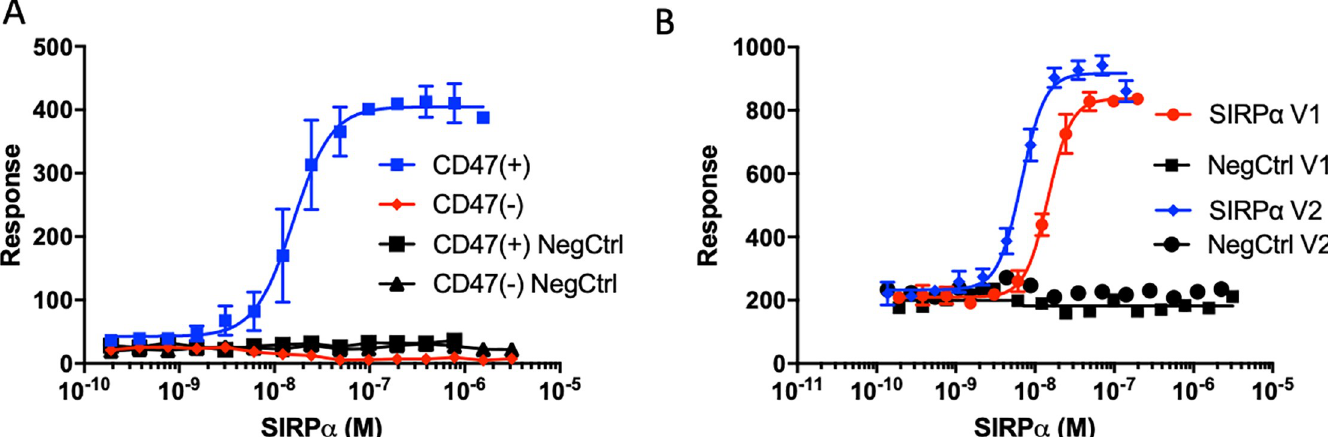
Fig 3. Quantitative measurements of SIRP α -CD47 binding using the optimized LSC assay platform. (A) Concentration-dependent SIRP α V2 binding to CD47(+) Jurkat cells using the LSC assay. Negative controls included are CD47(-) Jurkat cells and both CD47(+) and (-) cell lines incubated with NAV-488 and without SIRP α (NegCTRL, nonspecific binding). (B) Comparison of the binding affinities of SIRP α V1 and V2. Negative control indicates background nonspecific binding (-SIRP α ). Error bars indicate standard deviation of n = 4 replicates.